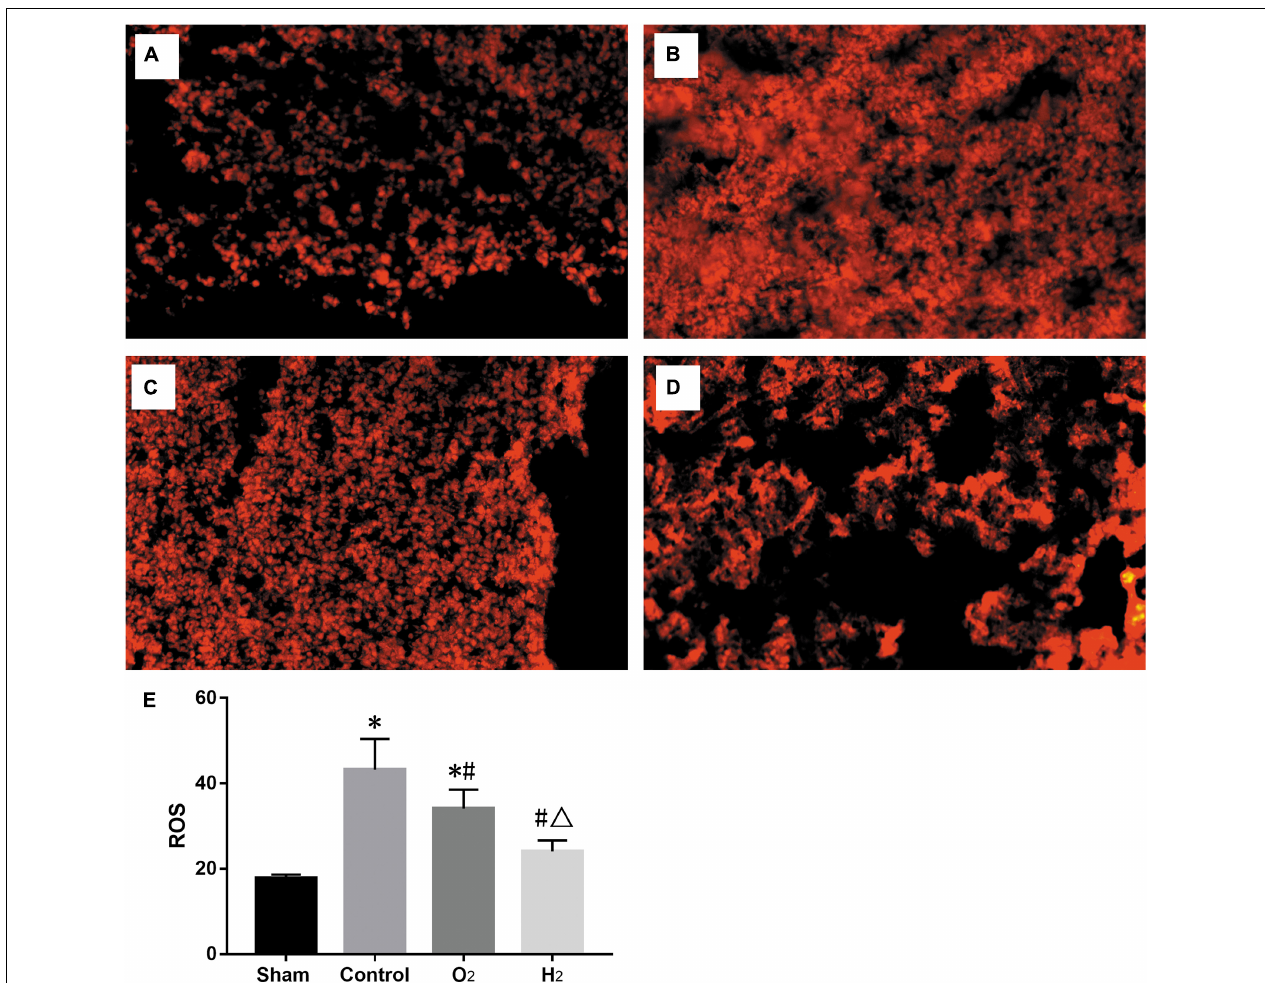
FIGURE 4 | The ROS stained with dihydroethidium imaged by fluorescence microscope. ( n = 3, original magnification, 20) (A) sham group; (B) control group; (C) O 2 group; (D) H 2 group; (E) the ROS levels in lung grafts. The ROS level in the control group was higher than the sham group ( P < 0.05), the ROS levels in the O 2 and H 2 group were lower than the control group ( P < 0.05), the H 2 group was lower than the O 2 group ( P < 0.05). ∗ P < 0.05 vs. sham group; # P < 0.05 vs. control group; (cid:77) P < 0.05 vs. O 2 group.